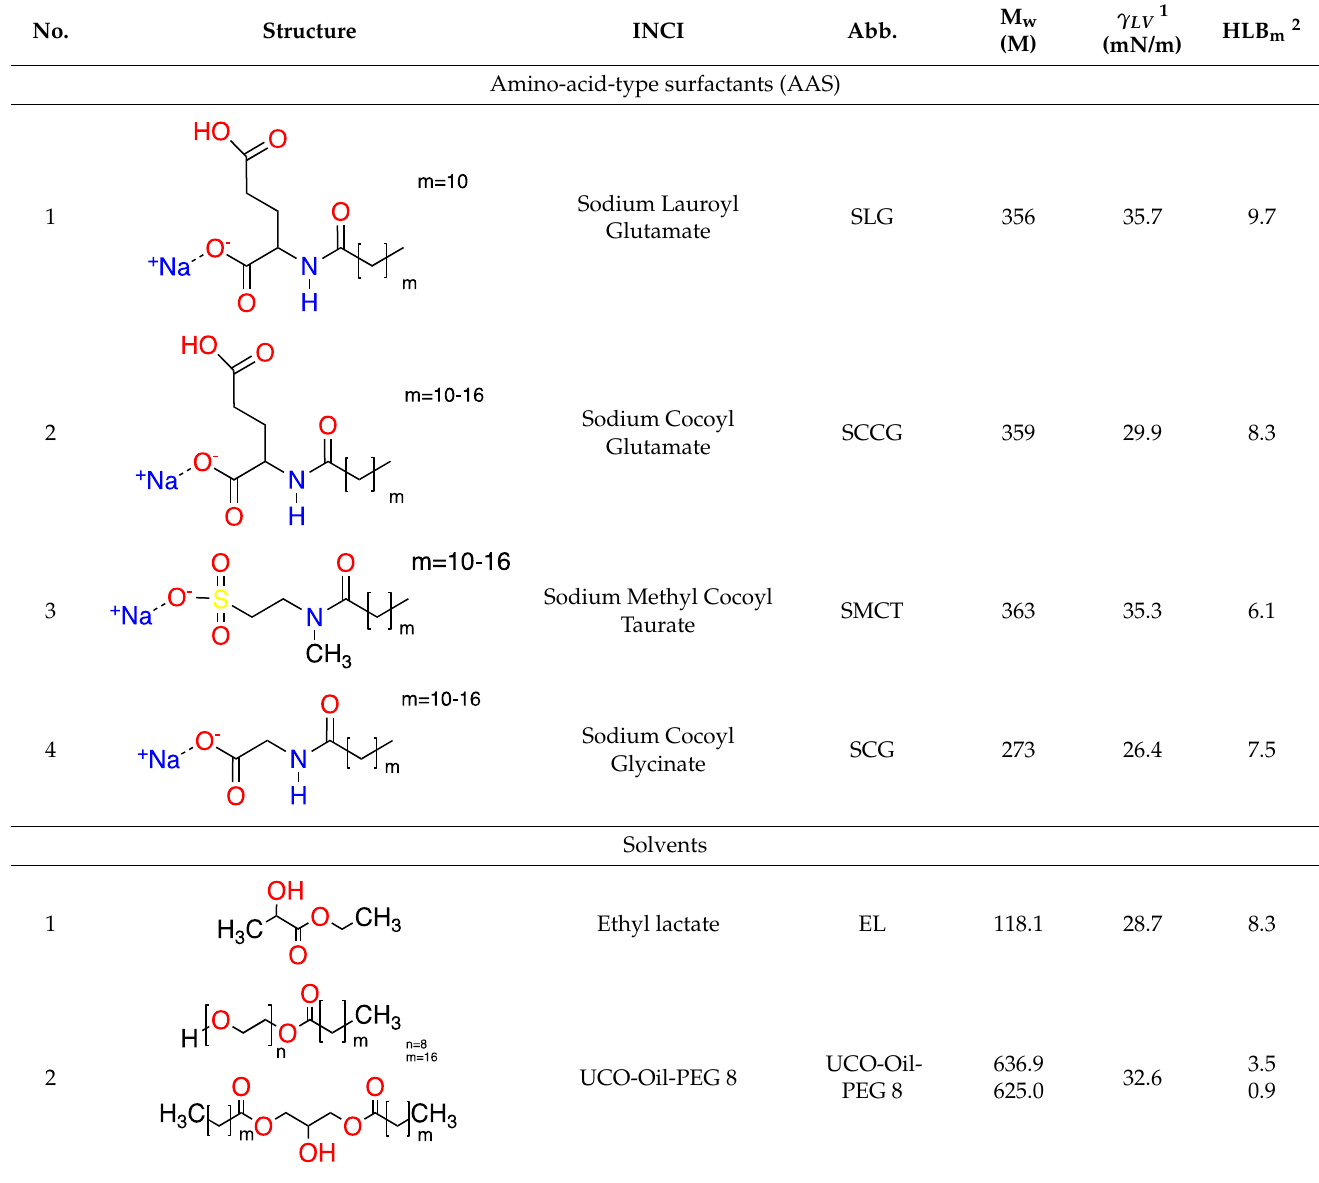
Table 1. Structures and abbreviations for the amino-acid-type surfactants (AAS) and biosolvents. No.